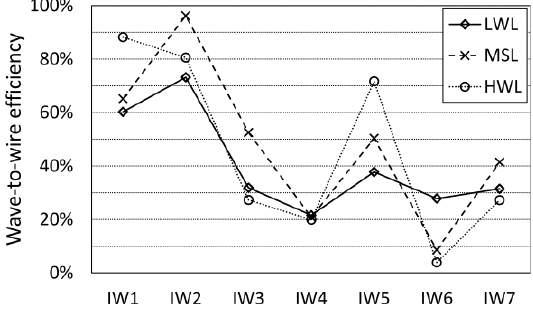
Fig. 13. Wave-to-wire efficiency of the OWC